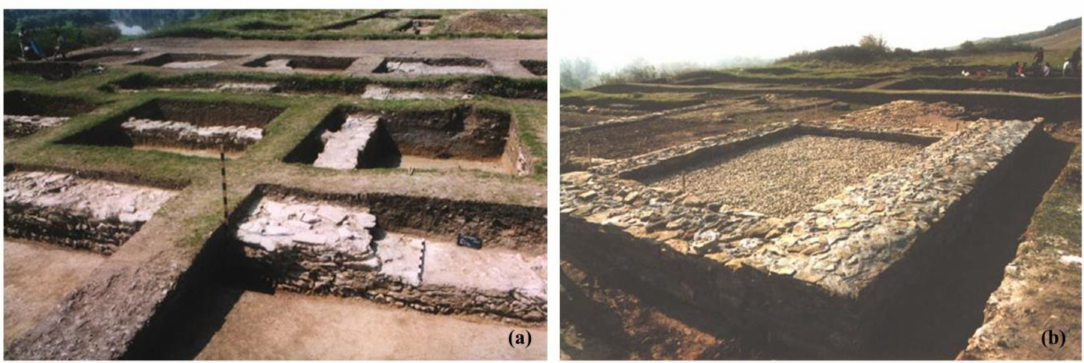
Figure 9. Germisara – Principia ( © [87]): ( a ) Excavation details; ( b ) Conserved north–east